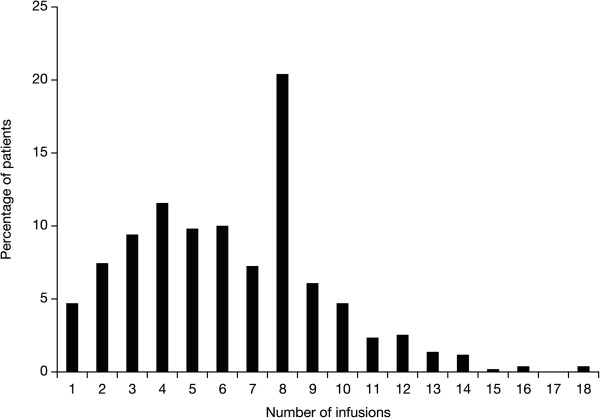
Distribution of the number of infusions of Mitoxantrone*. *Includes only patients who received at least one dose of Mitoxantrone.